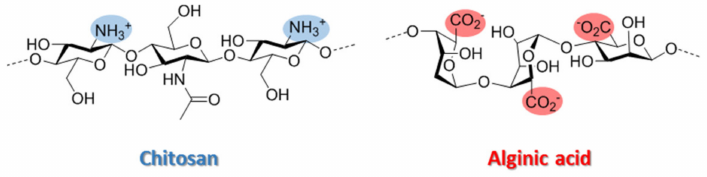
Figure 1. Chemical structures of chitosan and alginic